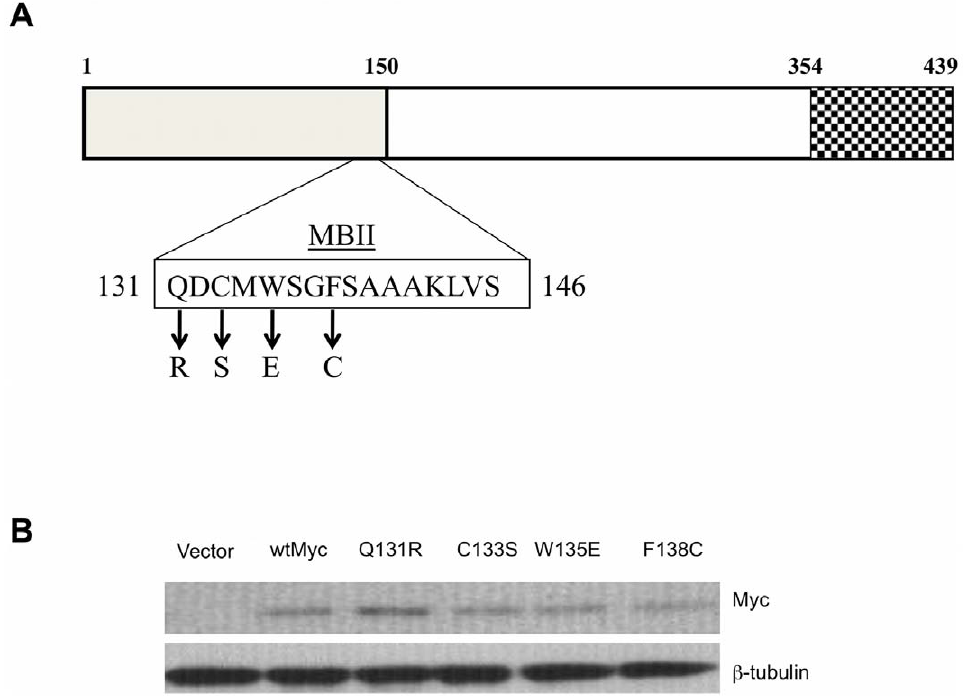
Figure 1. Expression of Myc mutants in Rat1a cells. ( a ) Diagram of the Myc protein. The approximately 150 residue TRD is shaded, with an expanded MBII domain and relevant amino acids substitutions depicted below the diagram. The basic-helix-loop-helix dimerization domain at the extreme C-terminus of the protein is indicated by the checkered box. ( b ) Each of the indicated mutations, along with wtMyc was expressed in Rat1a fibroblasts following lentiviral-mediated transduction. An empty lentiviral vector infection served as a negative control. Pooled, blasticidin-resistant colonies were subjected to western analysis for either Myc or b -tubulin, which served as a loading control. The monoclonal antibody used to detect human Myc proteins had some cross reactivity with endogenous rat